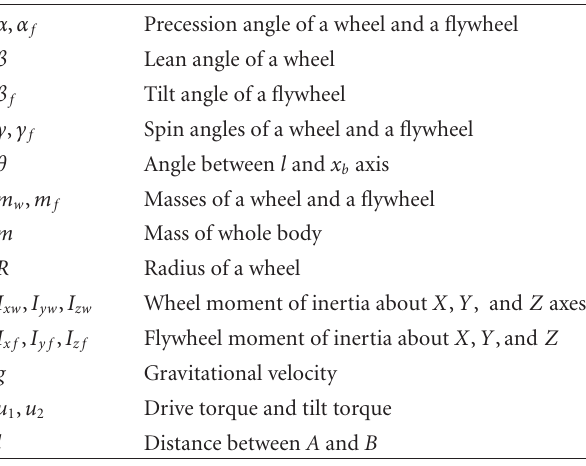
Table 1: Parameter